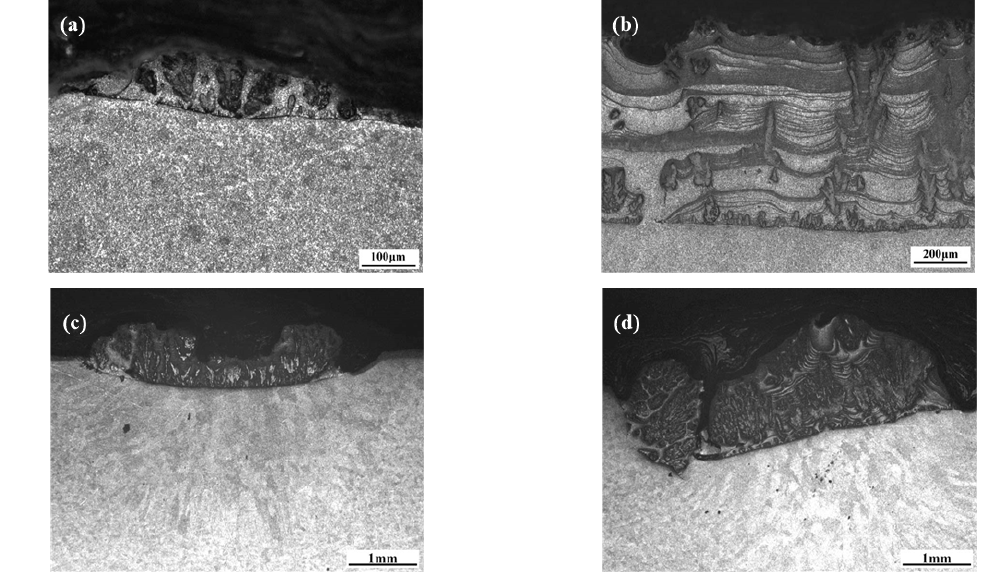
Figure 10. The macrostructures of nitrided layers prepared under N 2 flow rates of ( a ) 1 L / min, ( b ) 2.5 L / min, ( c ) 5 L / min, and ( d ) 7.5 L / min.